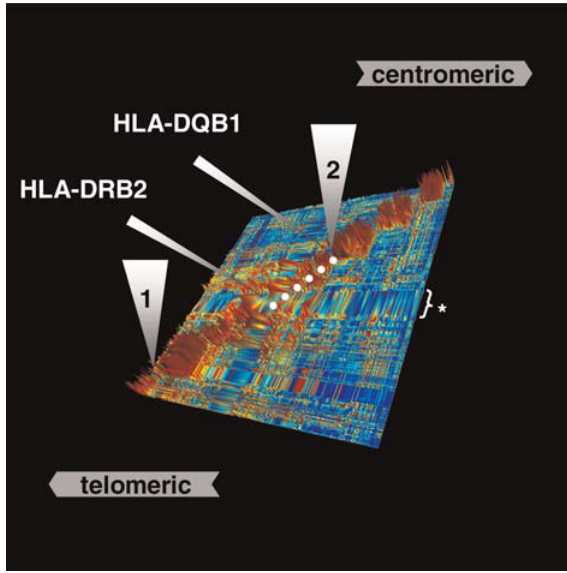
Figure 4. LD Structure around the HLA-DR Region High-resolution view of the HLA-DR region, as represented by GOLD- surfer three-dimensional view of D 9 values [81]. The position of the 158- kb segment shared by identical by descent between COX and QBL is shown by a dashed white line. High LD areas (red blocks) are separated by LD breaks. The first LD break (1) corresponds to a recombination hotspot mapped between NOTCH4 and C6orf10 in the class II–III boundary region. Another LD break (2) is visualized at another recombination hotspot centromeric of HLA-DQB1 at the boundary of the SNP desert between COX and QBL. This is followed centromerically by a further four LD breaks corresponding to recombination hotspots mapped at BRD2 / HLA-DOA interval, within HLA-DMB, within TAP2 and HLA-DQB2 /- DOB interval [5,51,53]. An asterisk (*) indicates a region of depleted SNP data, likely owing to substantial genotyping failure in an area with an extreme level of